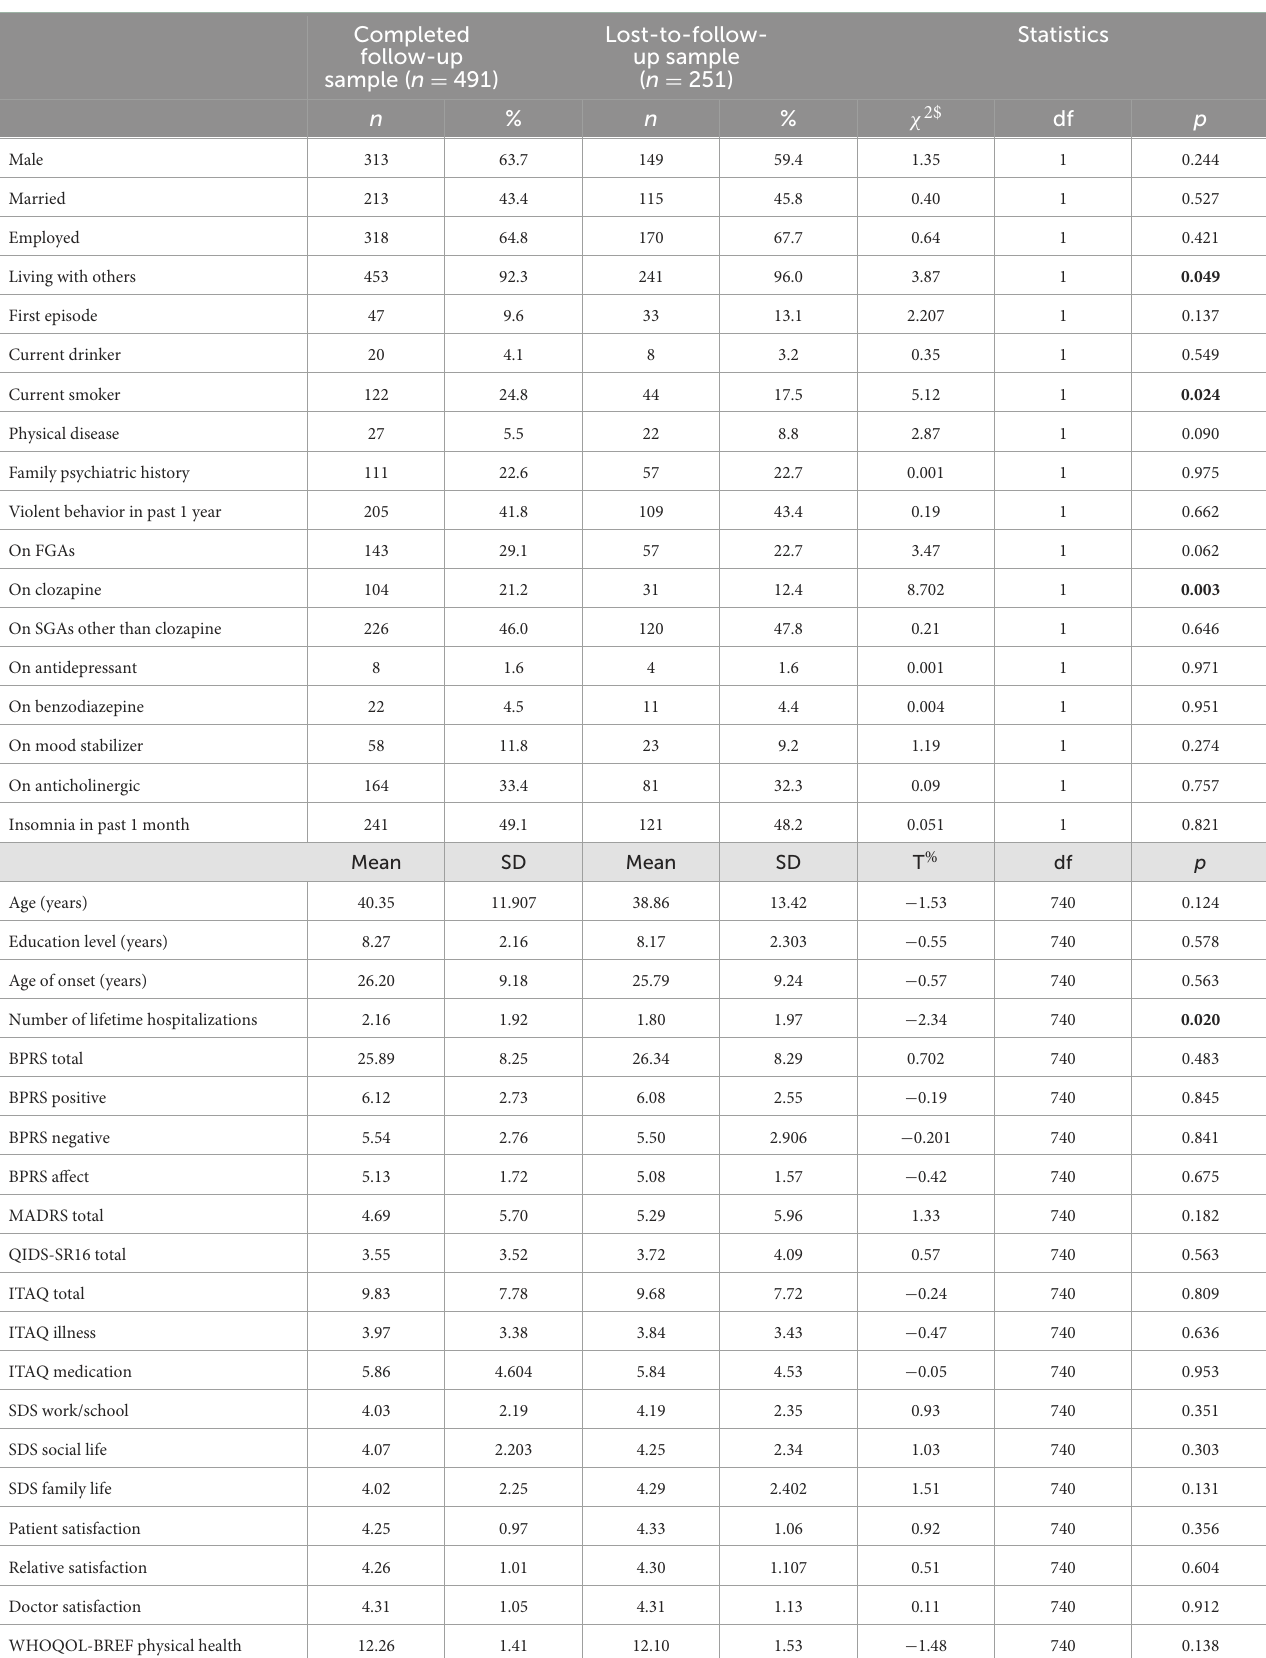
TABLE 1 Comparison of sociodemographic and clinical characteristics between the completed follow-up sample ( n = 491) and the lost-to-follow-up sample ( n = 251). Completed